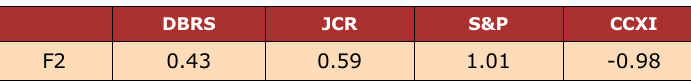
Table 8. The Assessment Value of Recognition